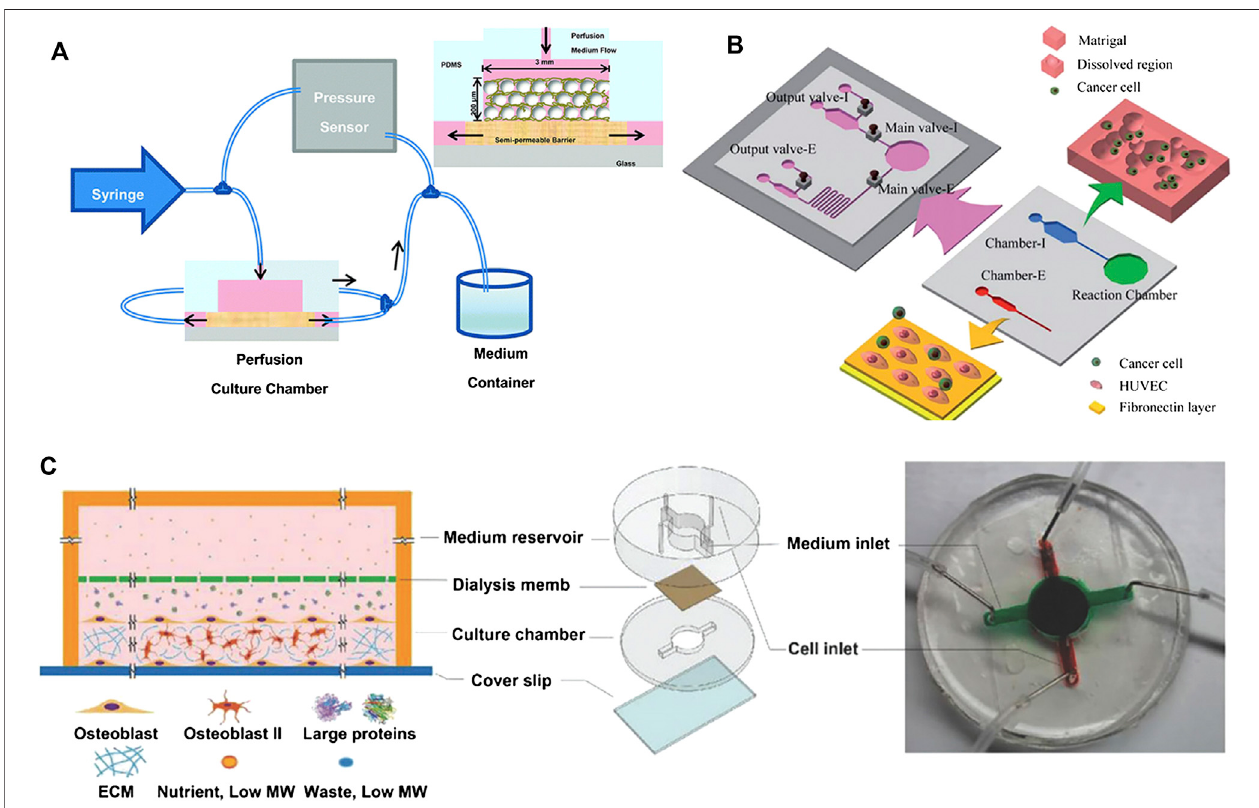
FIGURE 1 | Examples of micro fl uidic bone tissue model. (A) A 3D bone network structure was cultivated in a micro fl uidic chamber through microbead-guided reconstruction. Reproduced with permission from Gu et al. (2015). Copyright 2015, Royal Society of Chemistry. (B) A micro fl uidic chip that measures cell invasion and extravasation simultaneously. Reproduced with permission from Shin et al. (2011). Copyright 2011, Royal Society of Chemistry. (C) A 3D mineralized collagen bone tissue chip for coculture of breast cancer cells and osteoblasts. Reproduced with permission from Hao et al. (2018). Copyright 2018, Wiley-VCH.